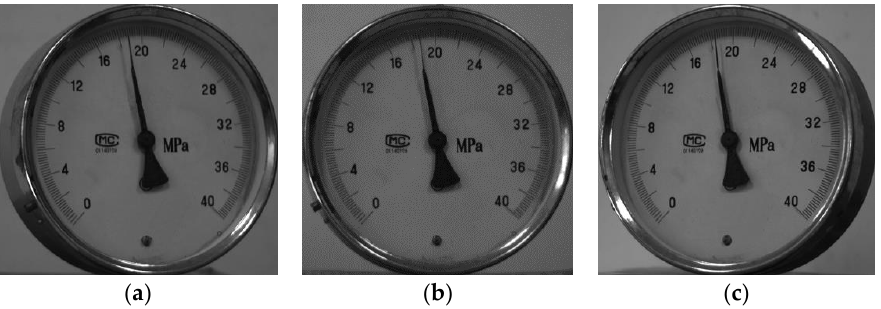
Figure A5. The meter image taken by camera from three angles when the reading of the pointer meter Figure A5. the meter image taken by camera from three angles when the reading of the pointer Figure A5. the meter image taken by camera from three angles when the reading of the pointer Figure A5. the meter image taken by camera from three angles when the reading of the pointer Figure A5. the meter image taken by camera from three angles when the reading of the pointer meter is 18.6; ( a ) the camera at position 1; ( b ) the camera at position 2; ( c ) the camera at position 3. is 18.6; ( a ) the camera at position 1; ( b ) the camera at position 2; ( c ) the camera at position meter is 18.6; ( a ) the camera at position 1; ( b ) the camera at position 2; ( c ) the camera at position 3. meter is 18.6; ( a ) the camera at position 1; ( b ) the camera at position 2; ( c ) the camera at position 3. meter is 18.6; ( a ) the camera at position 1; ( b ) the camera at position 2; ( c ) the camera at position 3.